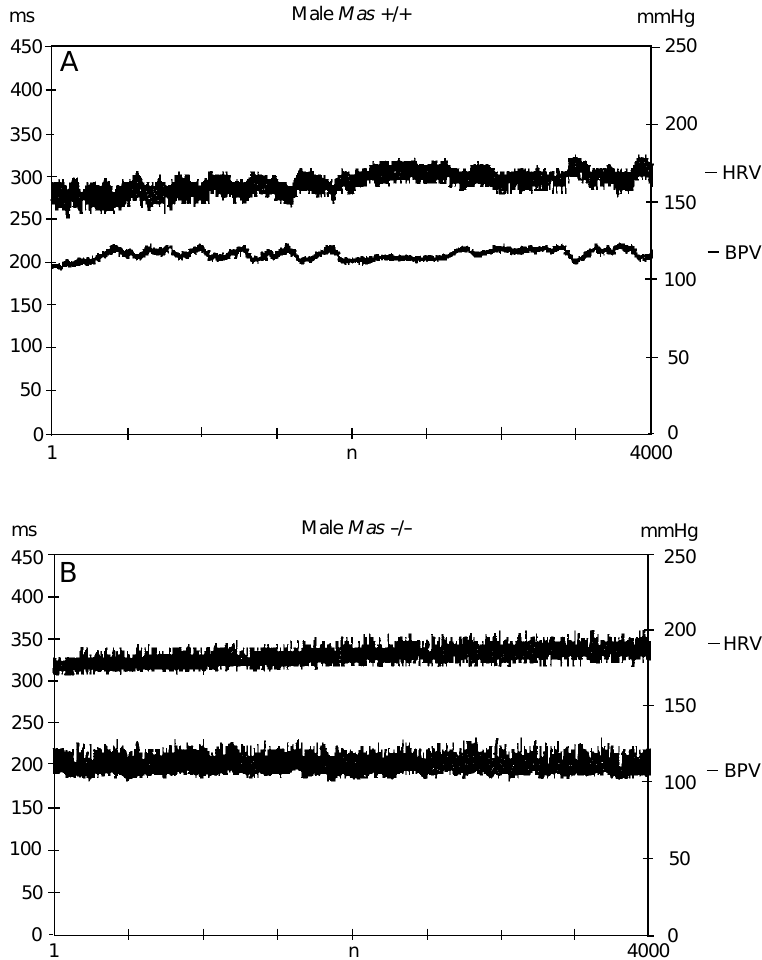
Figure 4 - Continuous measurement of heart rate (HR) in beats/min and systolic blood pressure (BP) in mmHg in a male wild-type (A) and a male Mas -deficient animal (B) for 16 s. HRV and BPV, Heart rate and blood pressure variabilities,